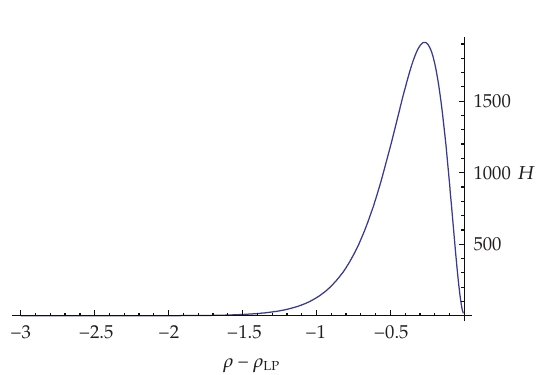
Figure 5: The function H in the massless-flavored KW model at zero